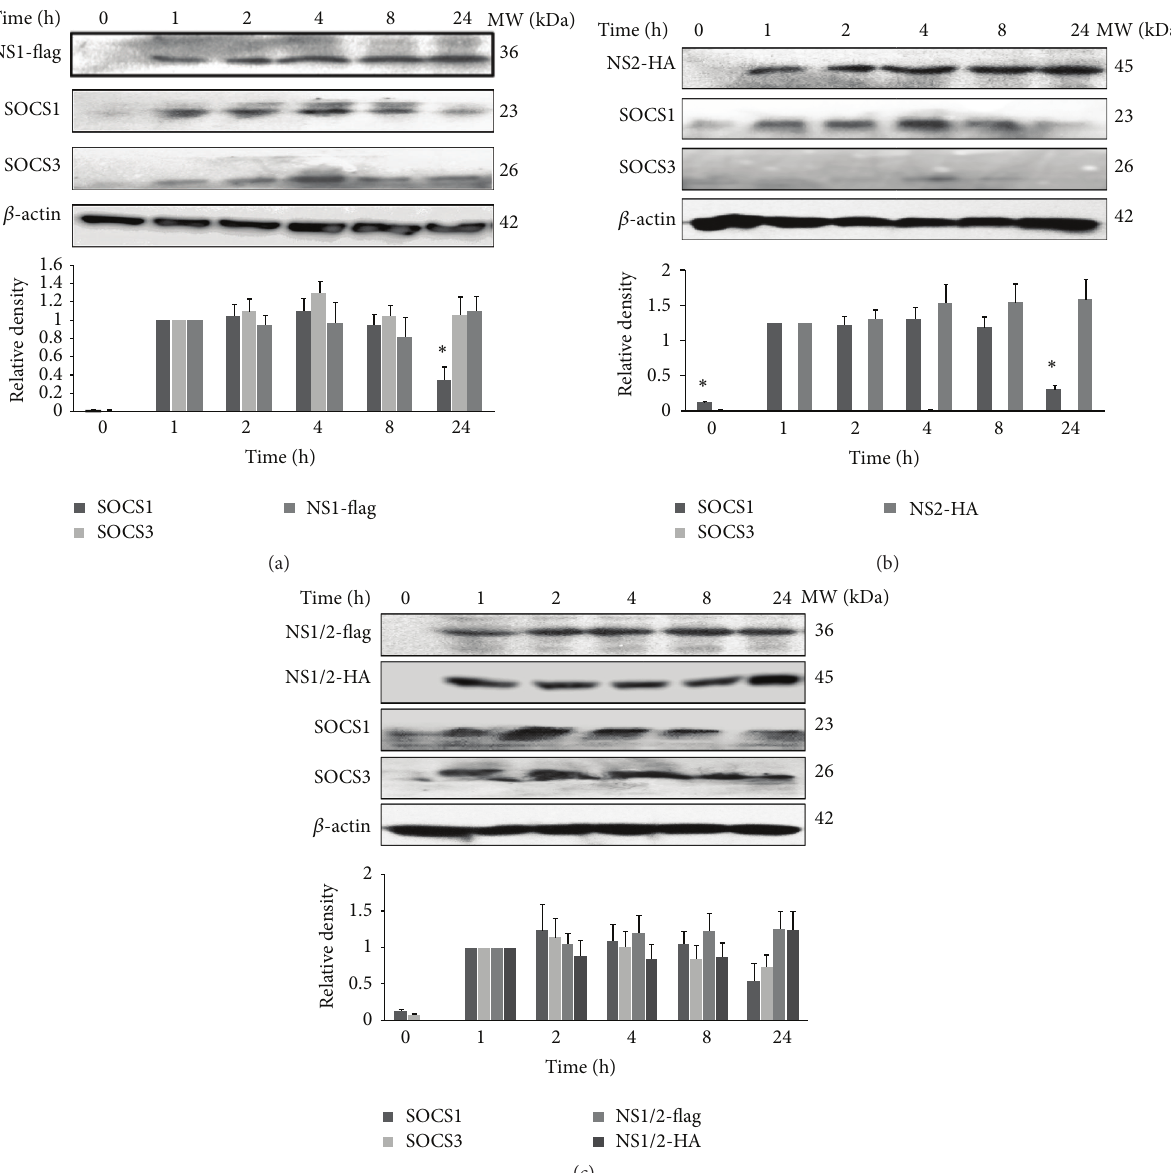
Figure 2: Nonstructural proteins NS1, NS2, and NS1/2 induced SOCS expression in A549 cells. A549 cells were transfected with NS1, NS2, NS1/2-expressing plasmids, or empty vector at final concentrations of 10 𝜇 g/mL, and then total cell lysates were subjected to Western blot analysis using the following antibodies: anti-SOCS1 (1: 500) and anti-SOCS3 (1: 500) at the indicated times. (a) pNS1 transfection upregulated the expression levels of SOCS1 and SOCS3 proteins. (b) pNS2 transfection upregulated the expression levels of SOCS1 but SOCS3